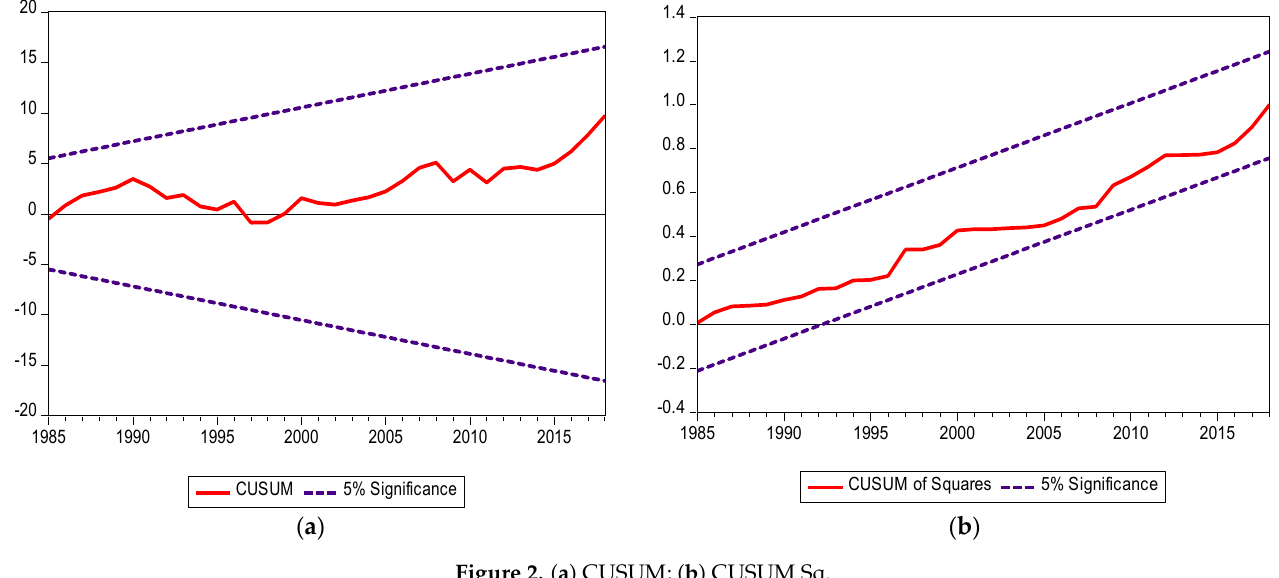
Figure 2. ( a ) CUSUM; ( b ) CUSUM Sq.